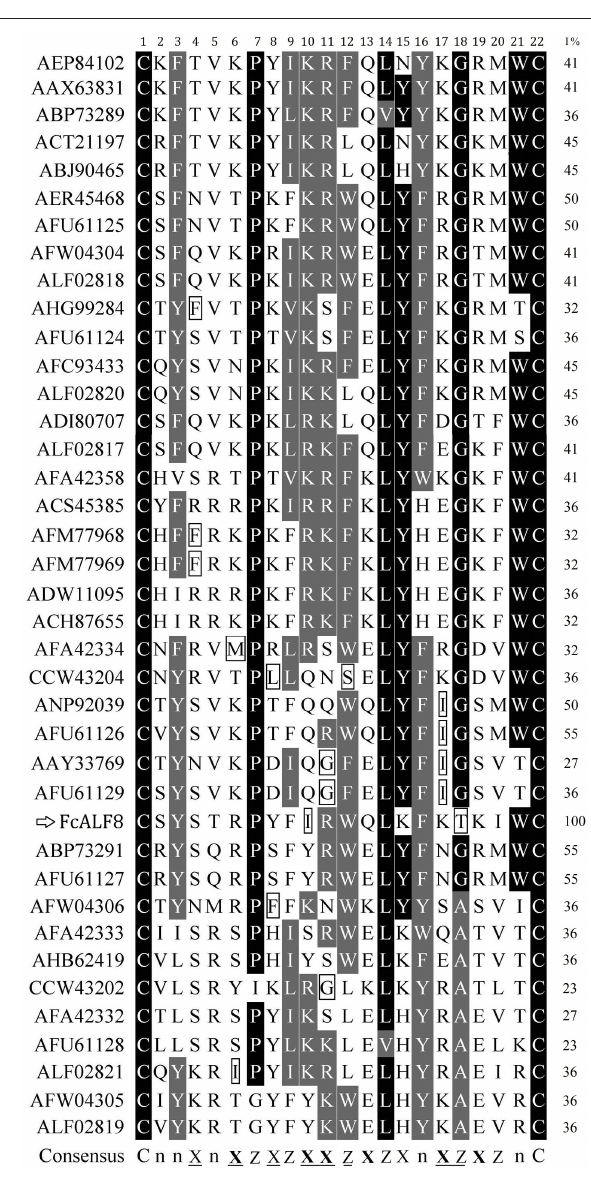
FIGURE 5 | Sequence alignments of LBD peptides from different ALFs. The LBD peptides were showed with GenBank accession numbers of corresponding ALFs listed in Table 2 . The amino acid residues in LBD sequences were numbered from 1 to 22. Identical and similar residues were shown in dark and gray, respectively. The % identities between LBD8 and other LBDs were listed in the right column (I%). The consensus sequence was generated by comparing the hydrophilic or hydrophobic properties of the amino acid residues in LBD peptides. In the consensus sequence, X showed hydrophilic residues, Z showed hydrophobic residues, and n showed variable residues. The underlined sites showed existence of < 4 residues with distinct property. Six bolded X indicated the sites frequent existence of basic or acidic residues among these LBD sequences. Two conserved cysteine residues (C) were shown at two sides of the consensus